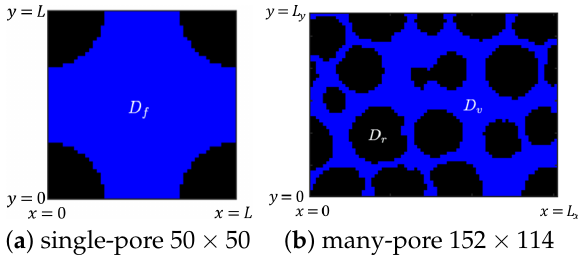
Figure 5. Notation for pore-scale domains used in simulations. Domain D f = D v is blue, D r is black. Left: domain D for single-pore experiments. Right: domain D for many-pore experiments, an imaged representative elementary volume (REV) from [6]. The single-pore domain on the left is an idealized subset of the many-pore domain on the right. Algorithm 1. Algorithm [Pore2K] for obtaining φ , K from D v